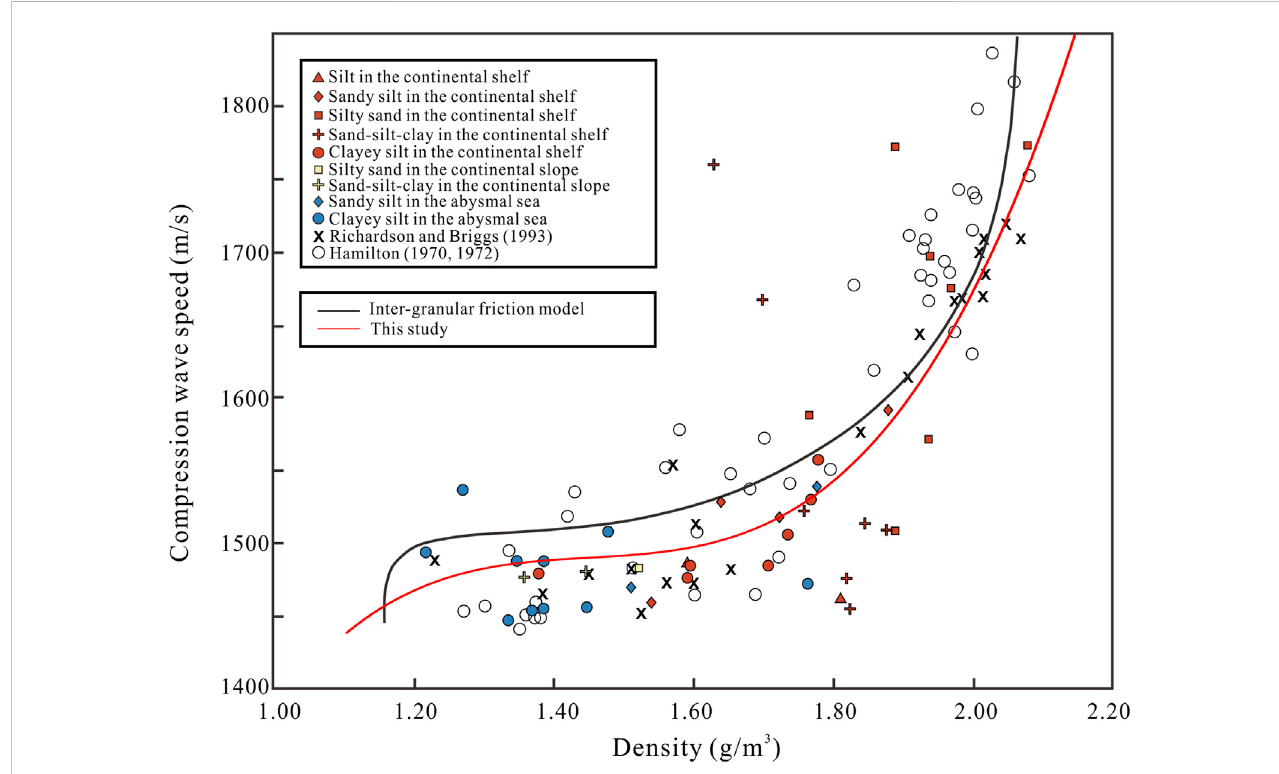
Relationship between the density and compression wave speed of sea fl oor